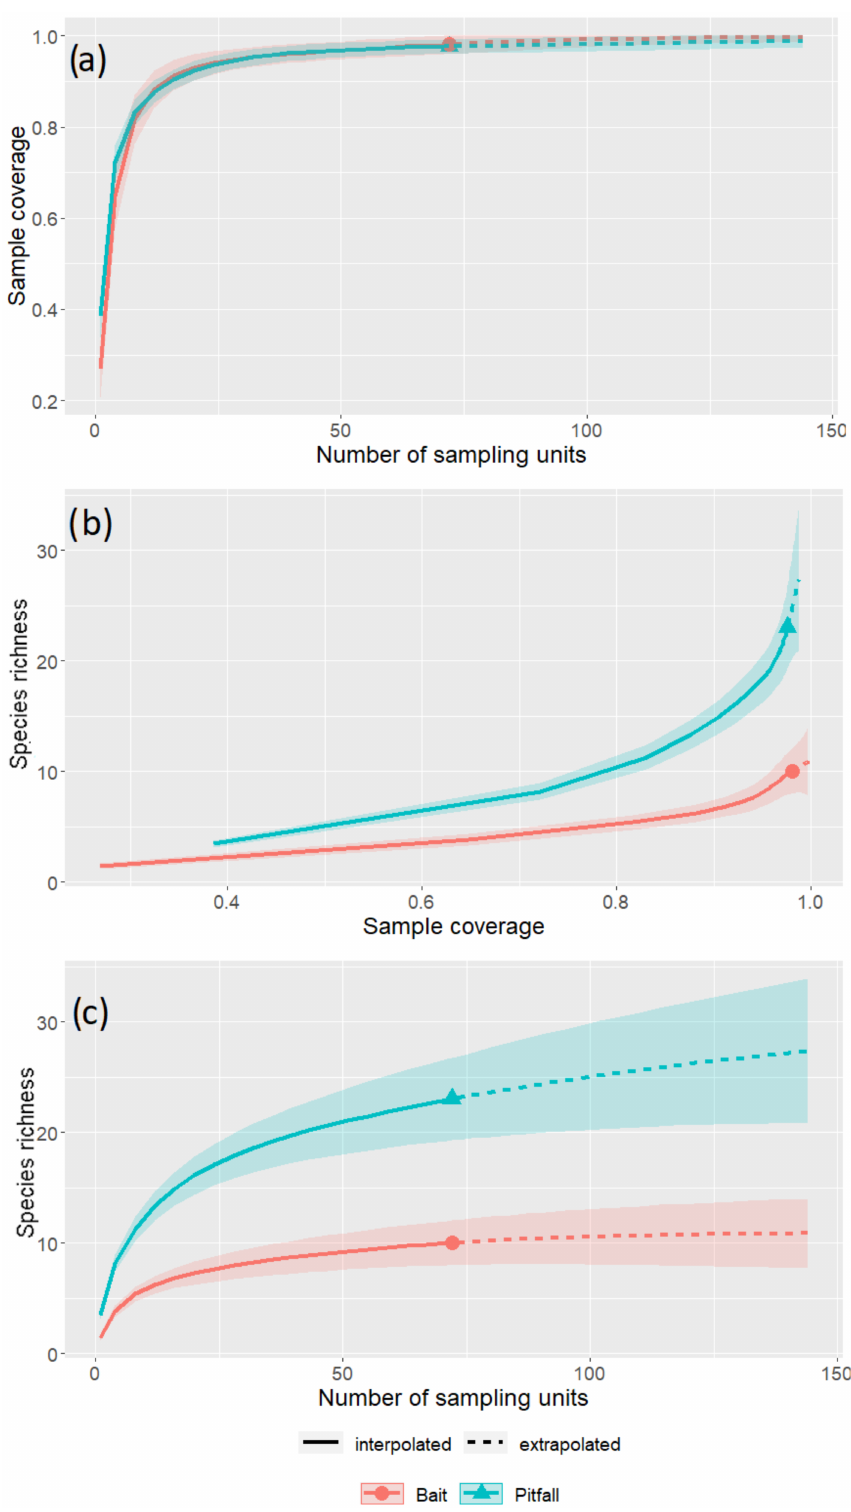
Figure 3. Estimated richness of ant assemblages from bait (red) and pitfall traps (blue) from the pooled data of the three sites. ( a ) Coverage vs. number of sampling units; ( b ) Species diversity vs. sampling coverage; ( c ) species diversity vs. number of sampling units. Plain line corresponds to observed data, while dashed line stands for extrapolated estimation. The colored area around the line is the standard deviation resulting from